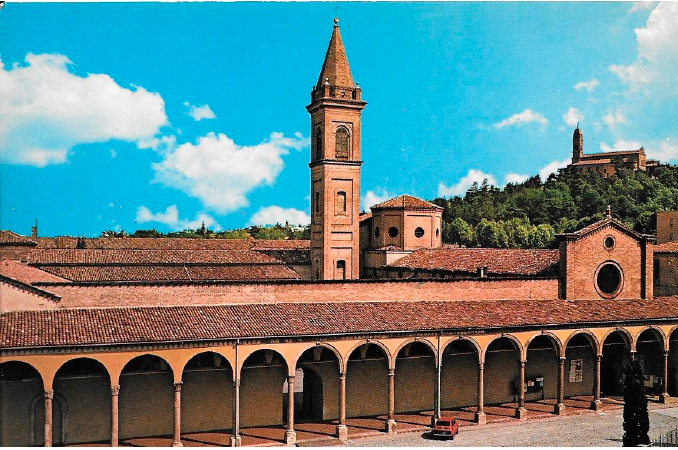
Figure 23. Tie rods in the portico of Chiesa di Santa Maria Annunziata, Bologna, Figure 24. Mechanism of stress transfer in the assumption of perfectly balanced in ‐ plane forces.